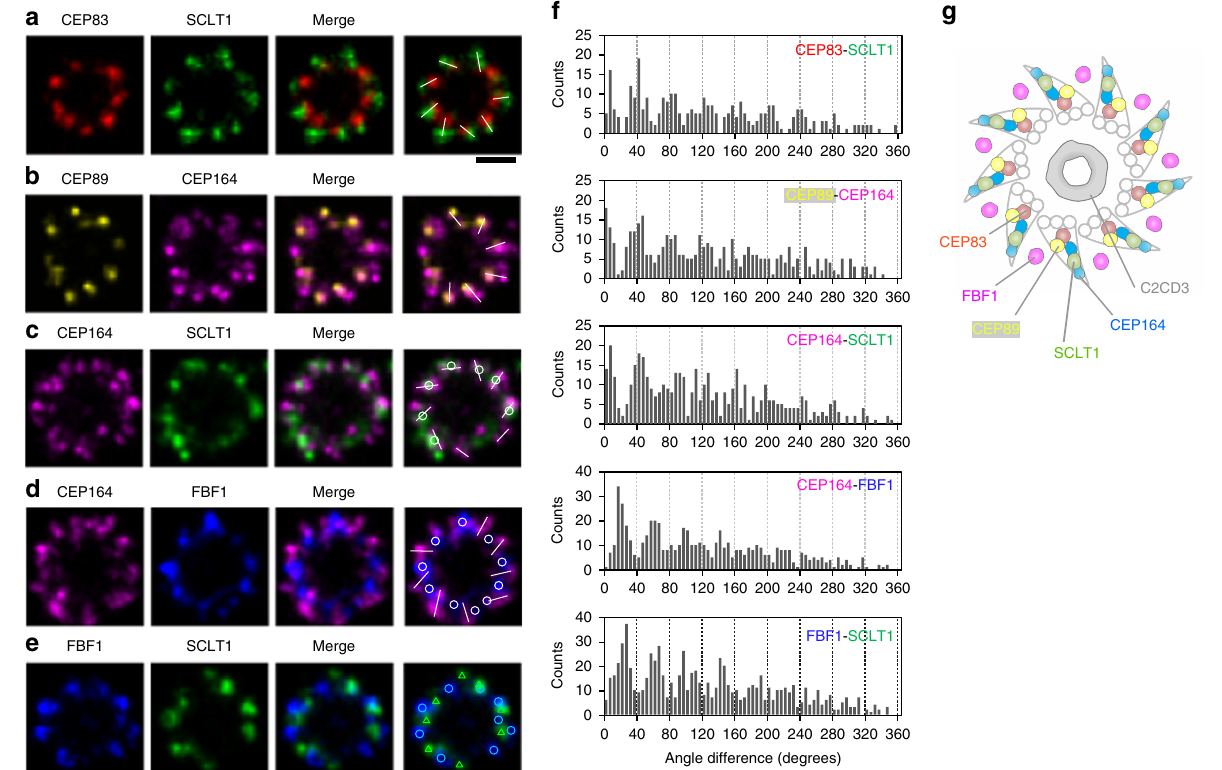
Fig. 2 Angular distributions of CEP83, CEP89, SCLT1, FBF1, and CEP164. a – e Two-color axial-view images of a CEP83-SCLT1, b CEP89-CEP164, c CEP164- SCLT1, d CEP164-FBF1, and e FBF1-SCLT1 pairs. CEP83 and SCLT1 a , and CEP89 and CEP164 b align well with each other. SCLT1 likely resides within each “ blade-like ” distribution of CEP164 signals c , whereas the angular positions of FBF1 puncta are different from those of CEP164 puncta d and SCLT1 puncta e . White bars mark SCLT1 in a or CEP164 in b – e ; circles mark SCLT1 in c or FBF1 in d – e ; triangles mark SCLT1 in e . f Angular analysis in the circumferential direction shows that CEP83, CEP89, SCLT1, and CEP164 exhibit similar angular distributions, while FBF1 is arranged alternately with SCLT1 or CEP164, suggesting it fi lls the gaps between adjacent CEP164 puncta. g Model of the localization of DAP proteins. FBF1 occupies the gaps between DAP blades, whereas C2CD3 localizes to the centriolar lumen. Bar a – e = 200